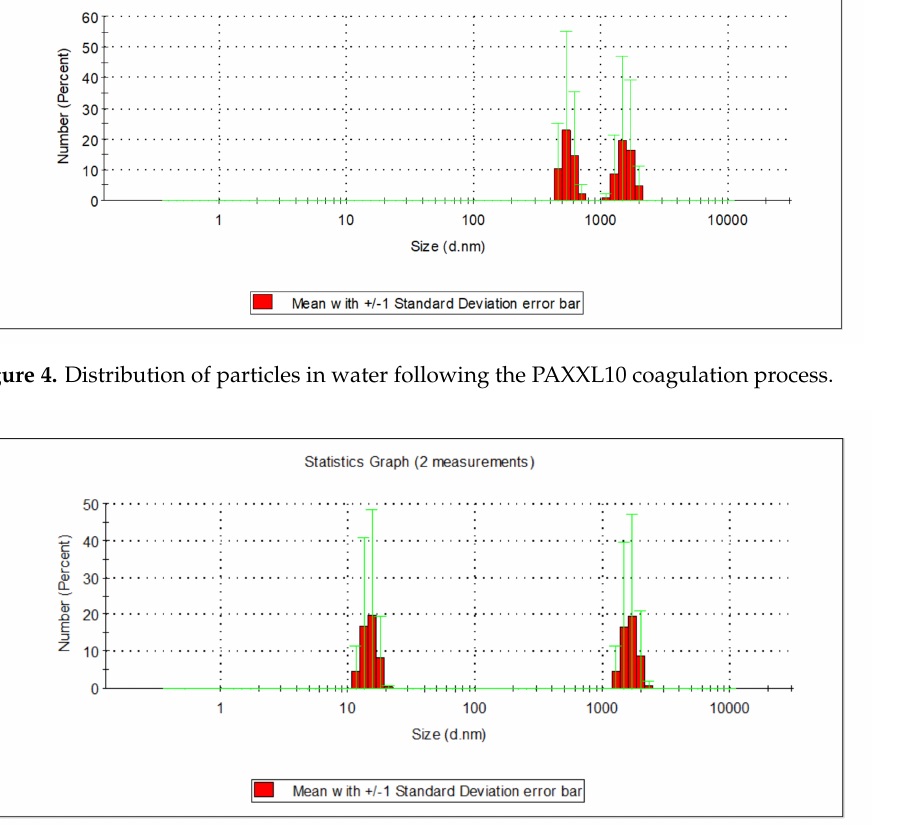
Figure 5. Distribution of particle size in water following the PAXXL1119 coagulation